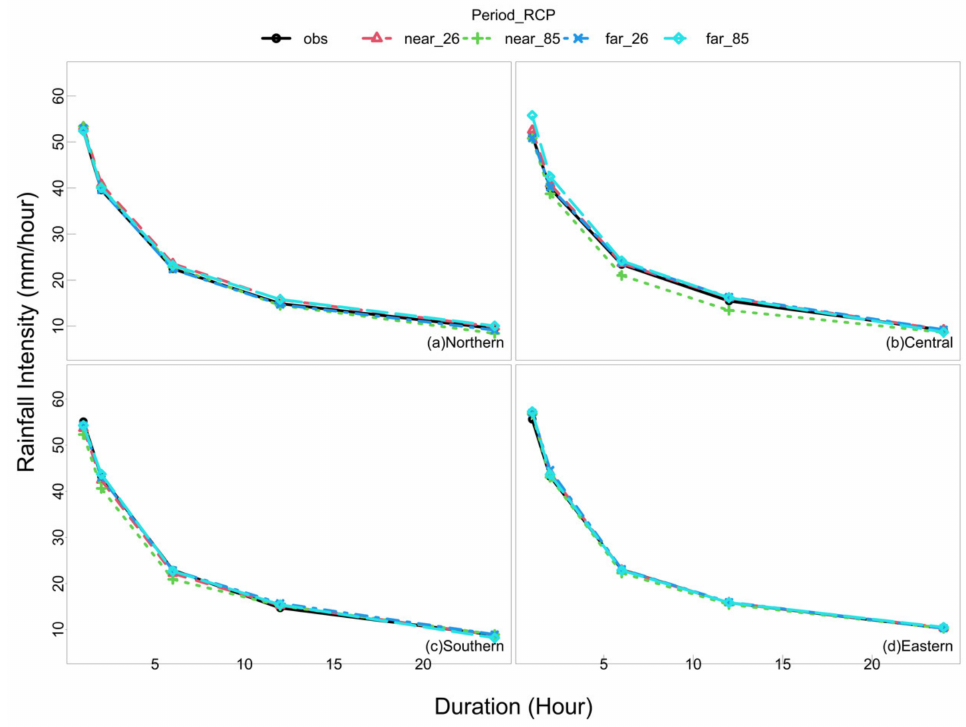
Figure 12. Rainfall intensities of 2-yr events (T2) of different durations for the four regions and four